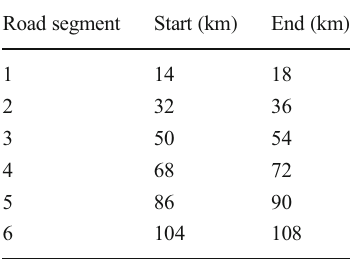
Table 2 Selection of road segments (km) for the analysis